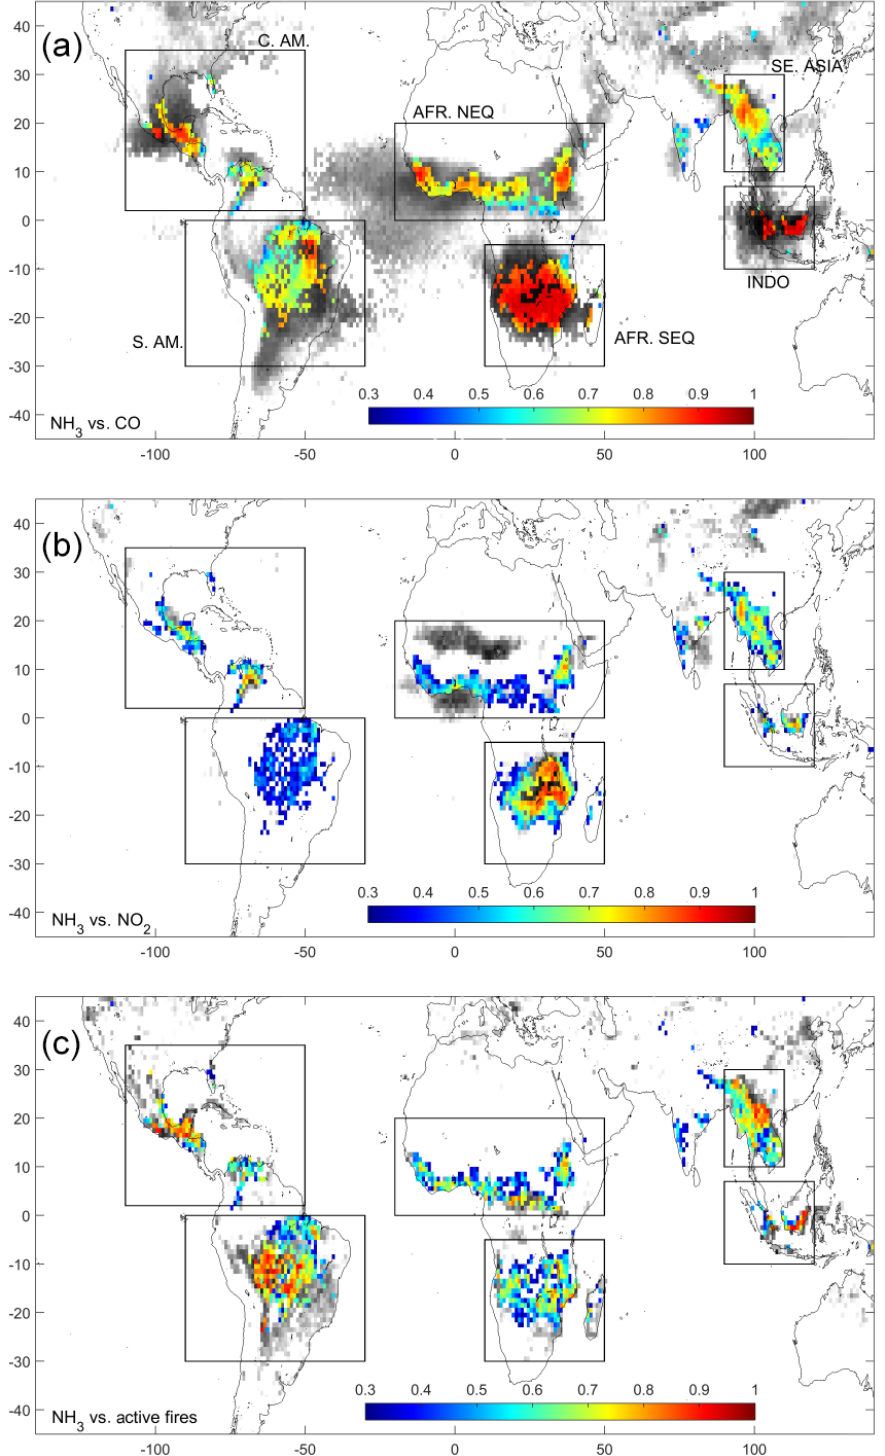
Figure 1. Correlation coefficients ( r ) of the linear regression of the monthly mean NH 3 total columns (moleccm − 2 ) vs. (a) CO total columns (moleccm − 2 ), (b) NO 2 total columns (moleccm − 2 ), and (c) the number of active fires from 2008 to 2015 in 1 ◦ × 1 ◦ cells. Only pixels with a correlation coefficient r higher than 0.3 are shown. Pixels with r > 0 . 3 for the three pairs of regressions are shown in color. Pixels with r > 0 . 3 for the considered pair but not for (at least) one of the two other pairs are shown in gray. The six regions selected for the study (C.AM., S.AM., AFR.NEQ., AFR.SEQ., SE.ASIA, INDO.) are highlighted by black